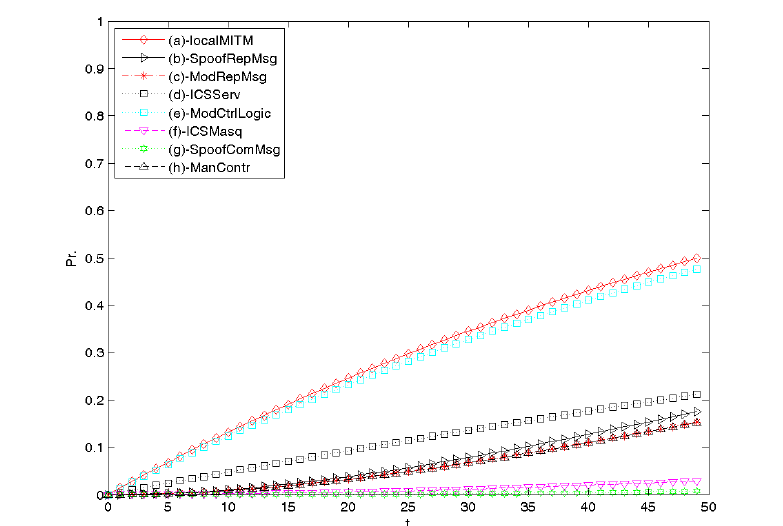
Figure 6. Probabilities of successful technique exploitation without monitoring